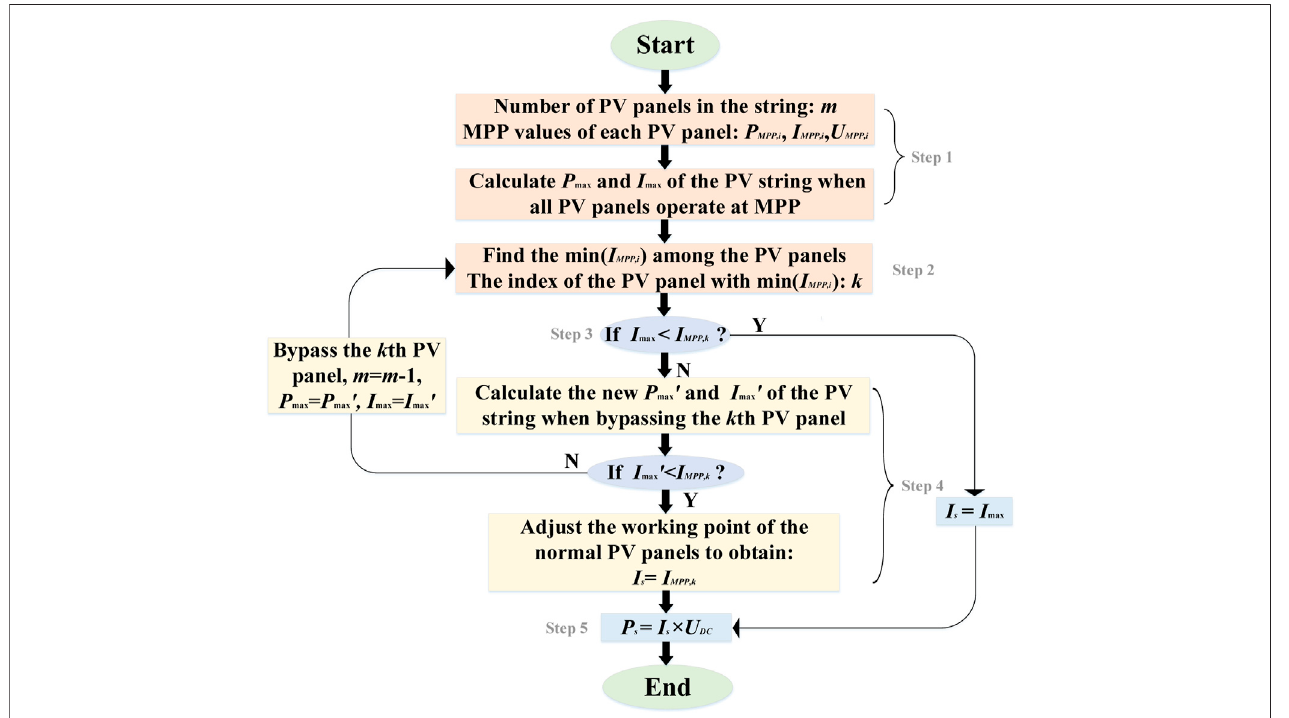
FIGURE 4 | Control strategy of DCOs with Boost